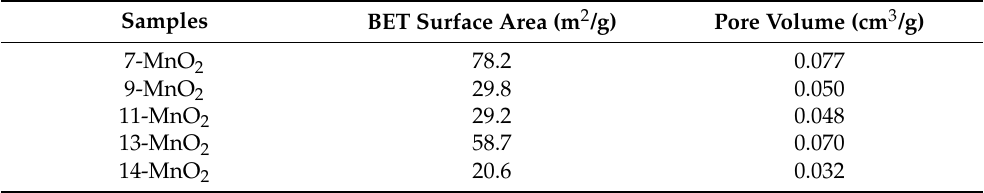
Table 2. BET specific surface area and pore volume of the five